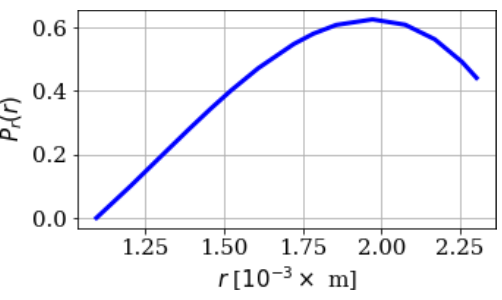
Figure 2. Probability of air bubble creation by large raindrops as a function of raindrop radius r (from Medwin et al.,